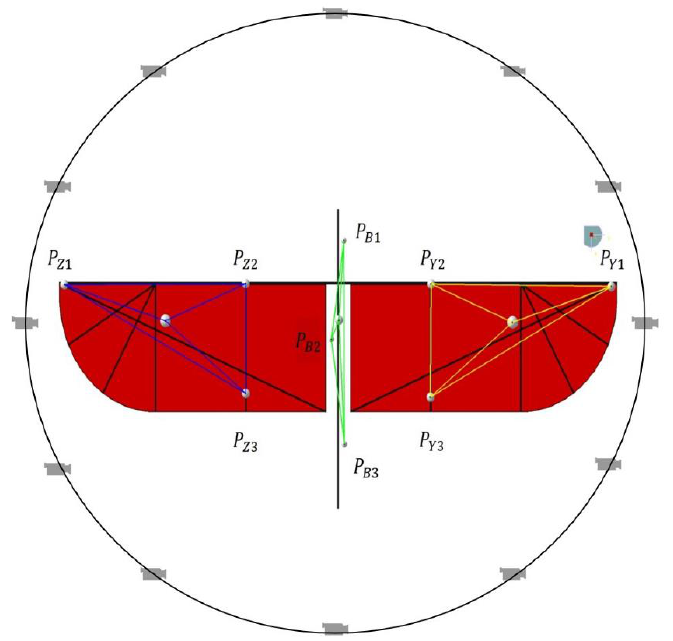
Figure 7. The OptiTrack motion capture system with 12 cameras positioned around the test model.